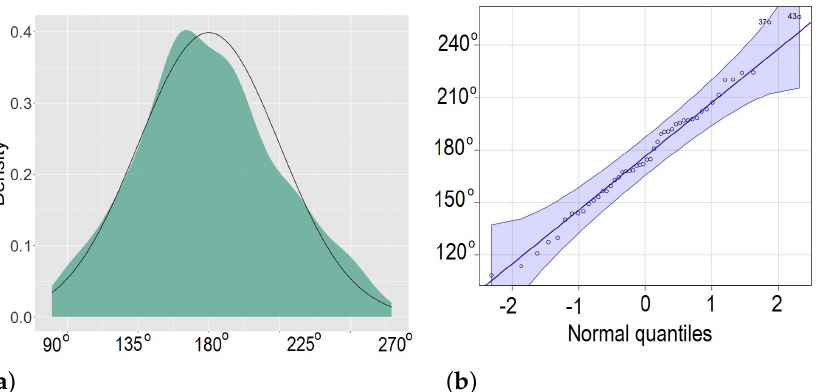
Figure 12. ( a ) The probability density plot of the line-drawing angles in Experiment 3, with a reference line representing the normal distribution N ( 180.29 ◦ ,8.18 ) fitted the data best. ( b ) The quantile–quantile normal probability plot shows quantiles of the empirical drawing angle distribution against quantiles of the normal distribution N ( 180.29 ◦ ,8.18 ) . The similarity of both distributions are justified by the fact that points are almost perfectly aligned along the diagonal line y = x . The shaded area defines the 95% confidence bounds for the normal distribution quantiles, with mean and standard deviation calculated from data